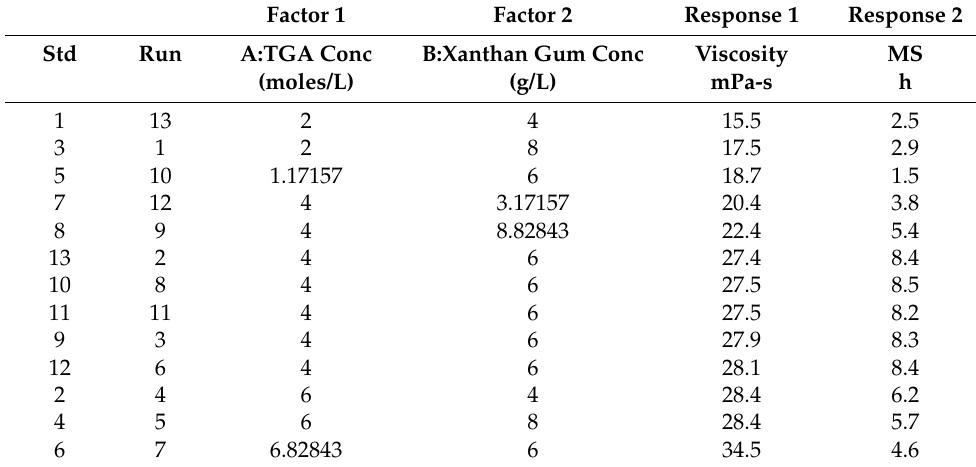
Table 3. Experimental runs projected and their responses observed.